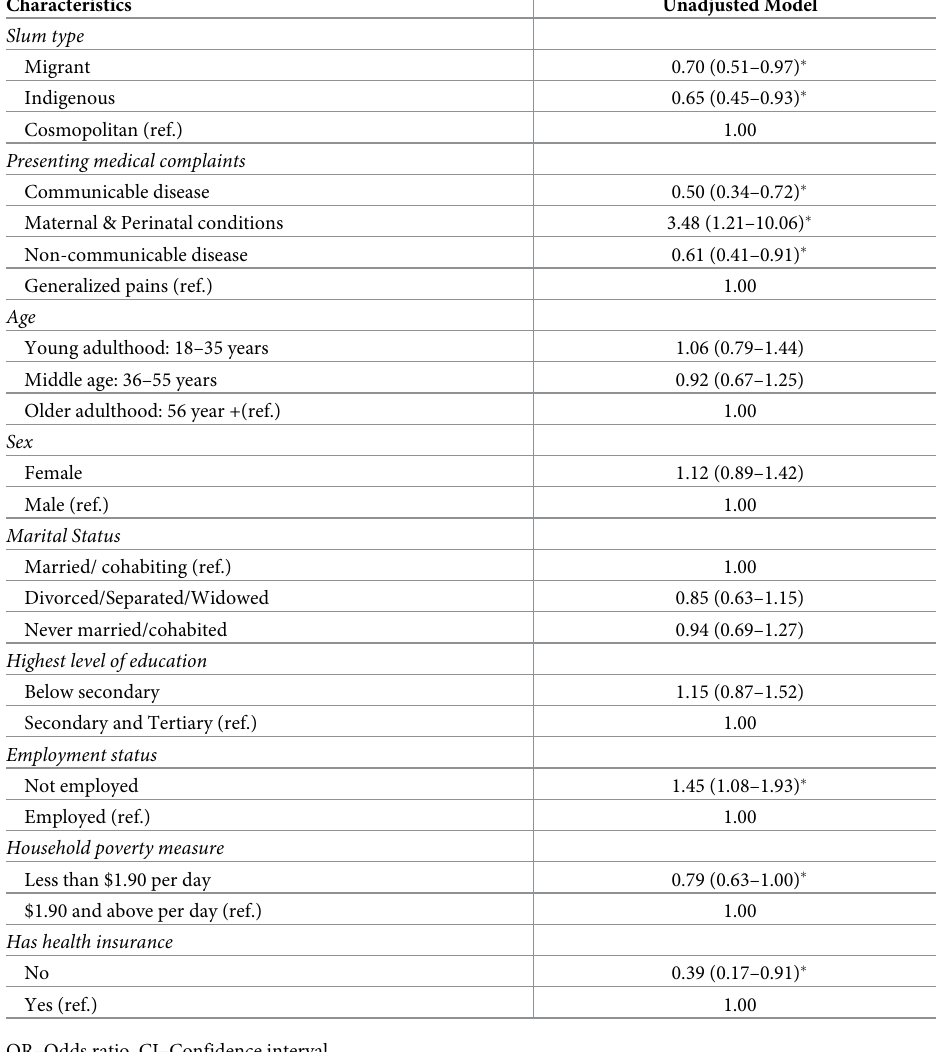
Table 4. Unadjusted odds ratios, with 95% confidence intervals of formal healthcare service use for environmental and population characteristics in urban slums in Nigeria.